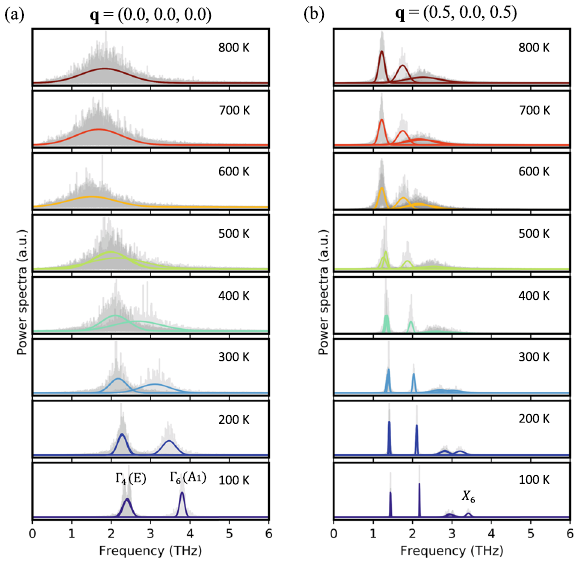
Fig. 5 Temperature dependence of the soft-modes obtained from MD simulations. Mode-projected phonon power spectra of GeTe at different temperatures for ( a ) zone center q = (0.0, 0.0, 0.0) and ( b ) zone boundary q = (0.5, 0.0, 0.5). The solid curves of different colors represent the data fi tted with a Lorentzian